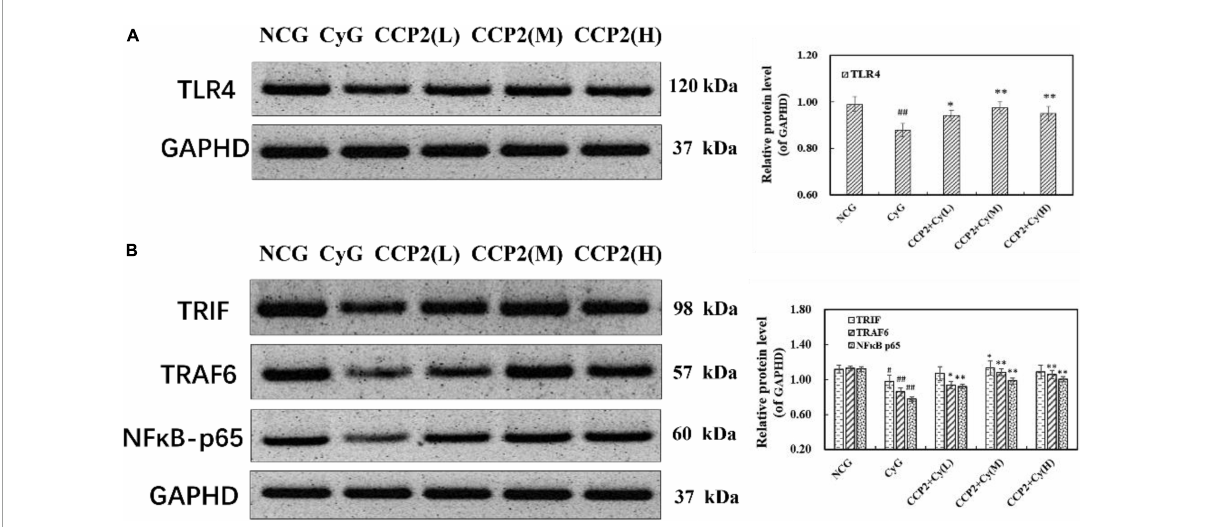
FIGURE6 Detection of the protein expressions of TLR4, TRIF, TRAF6, and phosphor-NF κ B-p65 by western blotting. (A) Effect of CCP on the expression of TLR4 in BALB/c mouse. (B) Effect of CCP on the expression of TRIF, TRAF6 and phosphor-NF κ B-p65 in BALB/c mouse. GAPHD was used as an equal loading control. # p < 0.05, ## p < 0.01 vs. the NCG group, * p < 0.05, * p < 0.01 vs. the CyG group. Data were expressed as means ± SD, n =